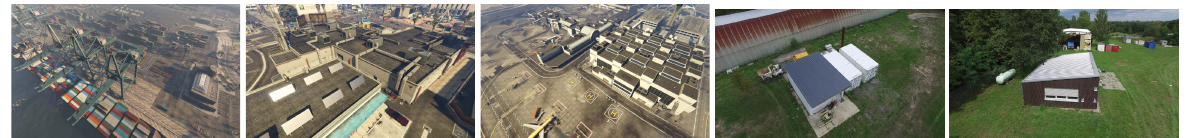
Figure 2. Examples from our datasets. The first three images are from the synthetic dataset and the other are from real world recordings. for the drift detected by performing a global bundle